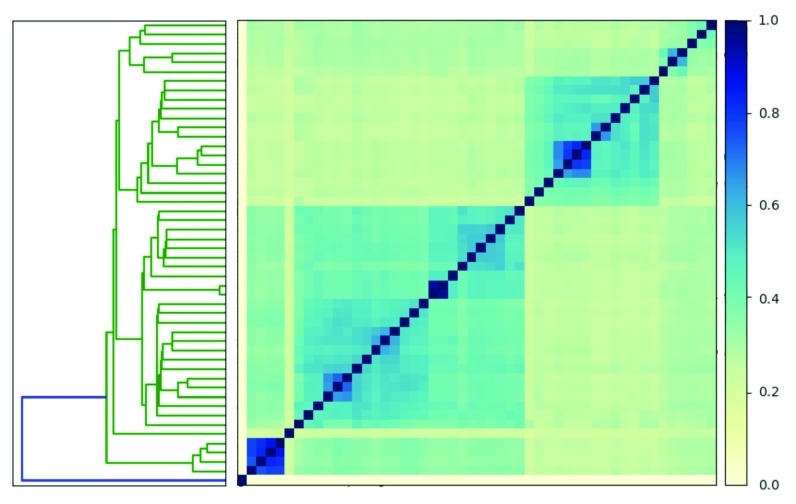
Heatmap and dendrogram generated using
sourmash signatures built from 50 genomes that contained the word “
Escherichia coli”.One signature is an outlier (highlighted in blue on the dendrogram).